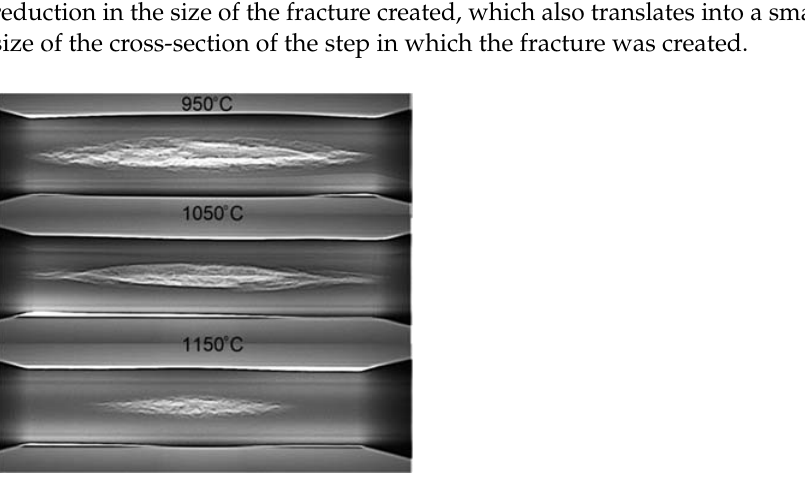
Figure 4. Internal cracks in the obtained forgings as shown in the X ‐ ray radiograph.